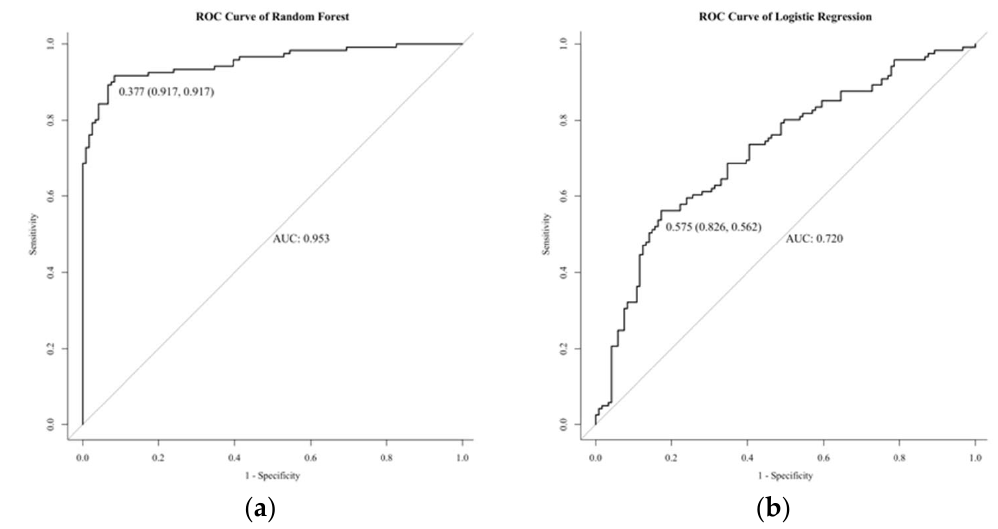
Figure 3. The histogram of treesize of the random forest model.